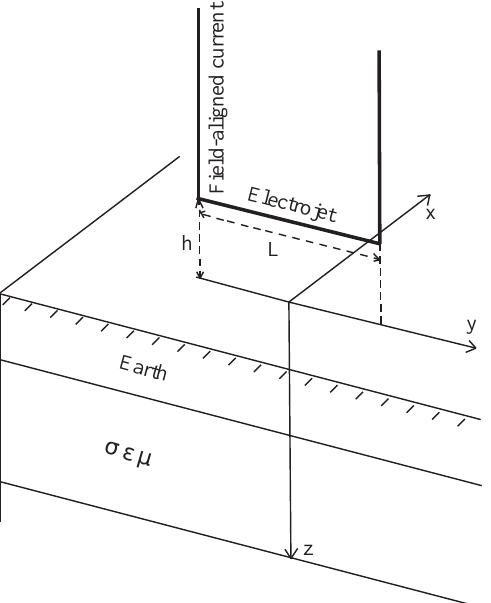
Fig. 1. Electrojet (amplitude I ) of a finite length L supplemented by vertical currents at the ends. The height of the electrojet is h , and the standard coordinate system with the earth’s surface as the xy -plane, the z -axis downward and the y -axis parallel to the electrojet is used in